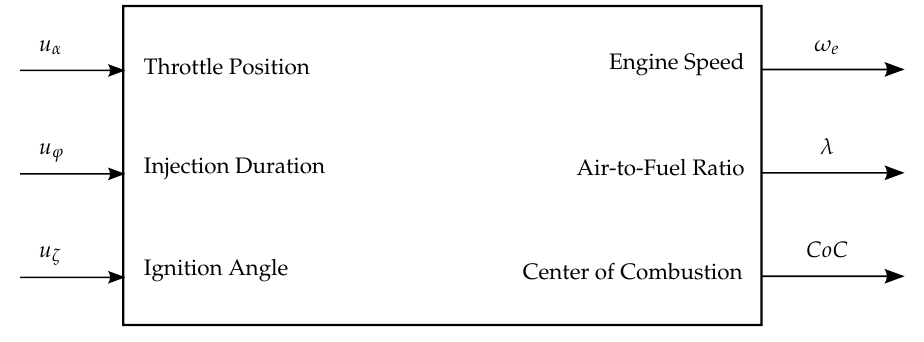
Figure 1. Inputs and outputs of the mean-value engine